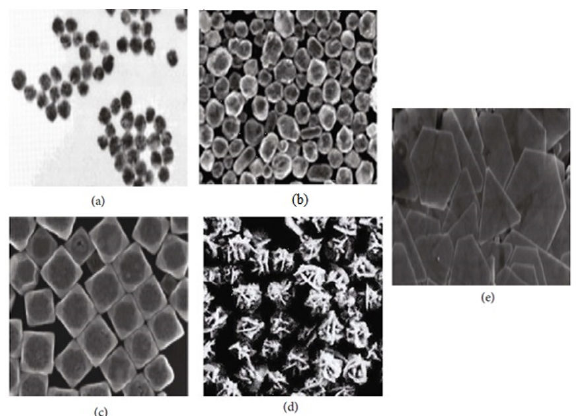
Figure 3. ( a ) Au nanospheres [11]; ( b ) Au nanoshells [12]; ( c ) Au nanocubes [13]; ( d ) Au nanoflowers [14]; ( e ) Au nanotri- angles [15]. Reprinted with permission from ref. [11–15]. Copyright 2002,2004,2008 The Journal of Physical Chemistry